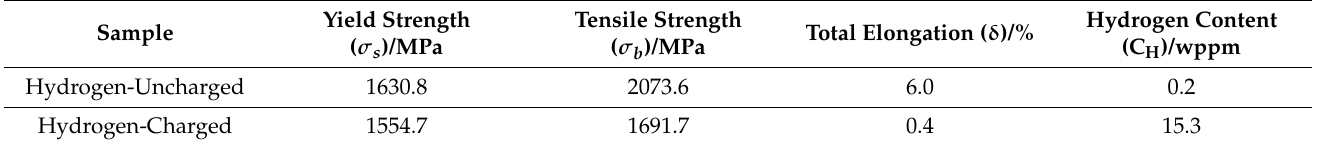
Table 1. Mechanical properties of Al 0.5 Cr 0.9 FeNi 2.5 V 0.2 specimens with and without hydrogen charg- ing.